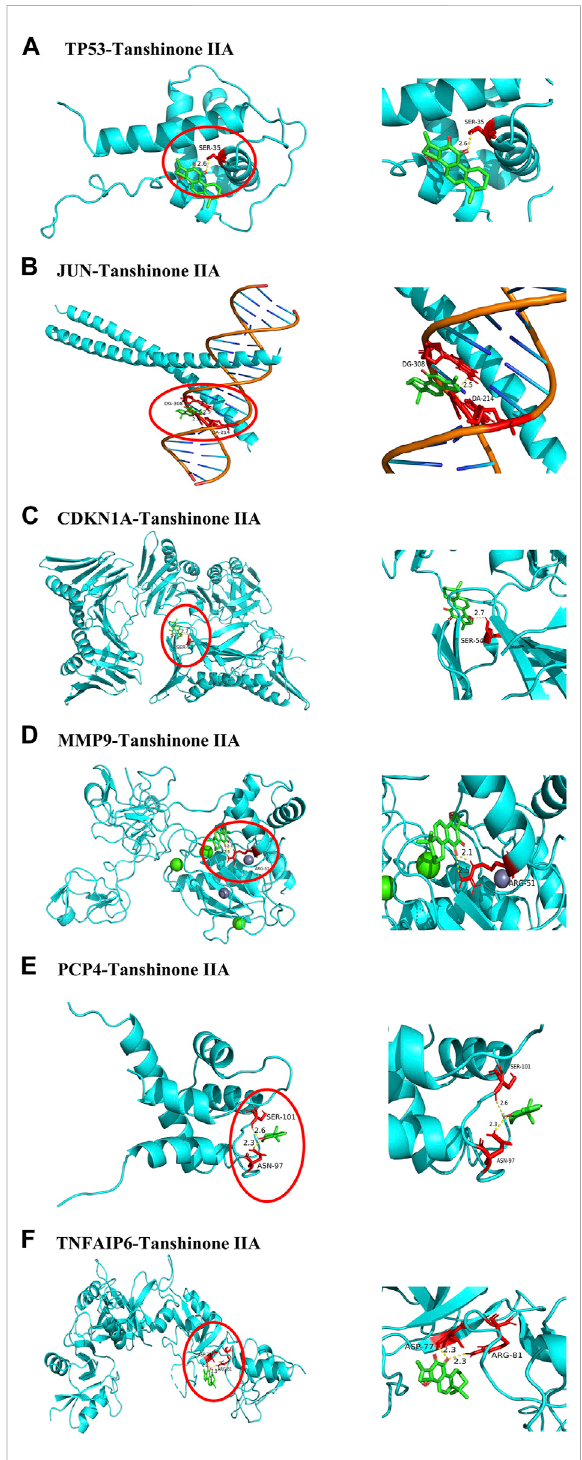
FIGURE 9 Core protein docking with small molecules. The molecules and drugs with the lowest docking energies are visualized in Figure 8, JUN,TP53,MMP9,PCP4, CDKN1A AND TNFAIP6 proteins and Tanshinone 2A. Small molecule drugs and interacting amino acids are red, proteinsare blue, their interactions are yellow dotted lines, and numbers are bond